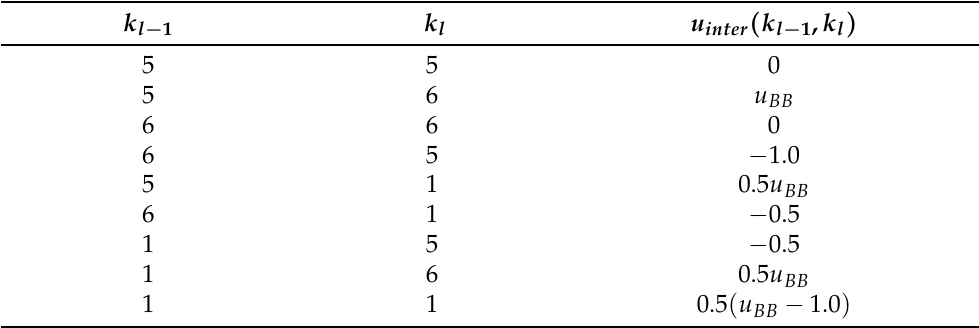
Table 2. Interlayer energies between neighboring layers (per site) for differently oriented